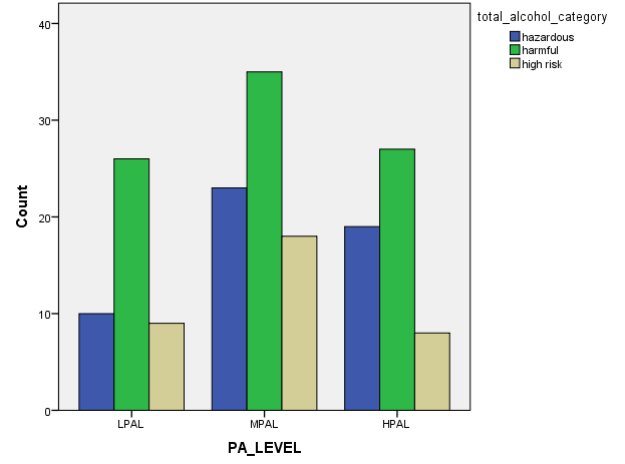
Figure 7. Frequency of tobacco and alcohol consumption depending on physical activity level (male).